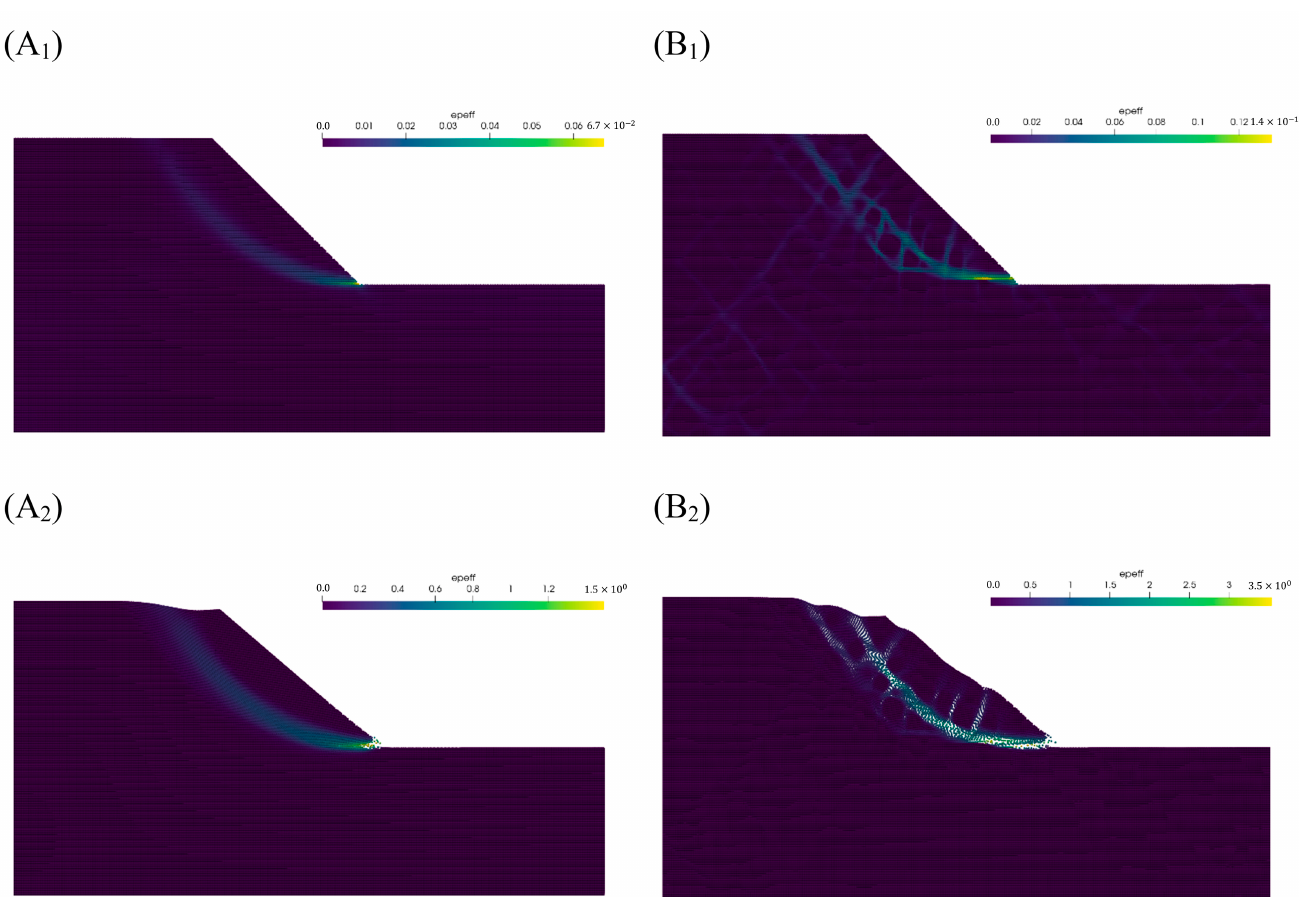
Figure 6. Change of plastic zone of slopes before & after instability. ( A 1 ) Distribution of the plastic zone at the instability of the pure soil slope ( K SRF = 1.3); ( A 2 ) Distribution of the plastic zone at the instability of the pure soil slope ( K SRF = 1.5); ( B 1 ) Distribution of plastic zone at the instability of the SRM slope ( K SRF = 1.7); ( B 2 ) Distribution of plastic zone at the instability of the SRM slope ( K SRF = 1.9).